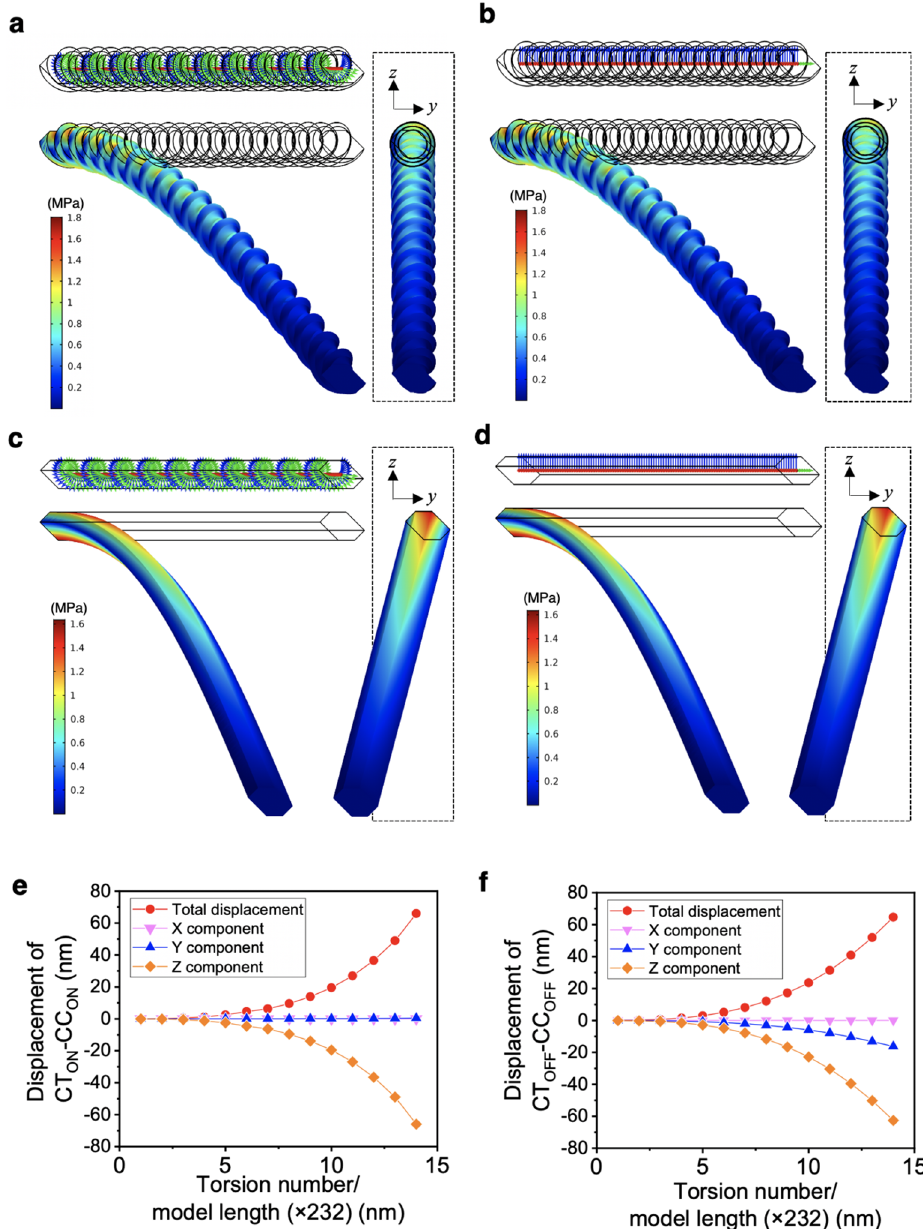
Figure 4. Effects of a contour twist and curvilinear coordinates on bending deformation. Internal coordinates and von Mises stress distributions for typical 10-round twist or equivalent 2320 nm length models with ( a ) CT ON -CC ON , ( b ) CT ON -CC OFF , ( c ) CT OFF -CC ON , and ( d ) CT OFF -CC OFF . Displacements in each direction for the 1- to 14-round twist models (corresponding to 232 to 3248 nm in length) of ( e ) CT ON -CC ON and ( f ) CT OFF - CC OFF . The simulation model figures were exported by COMSOL Multiphysics 5.4 (https ://www.comso